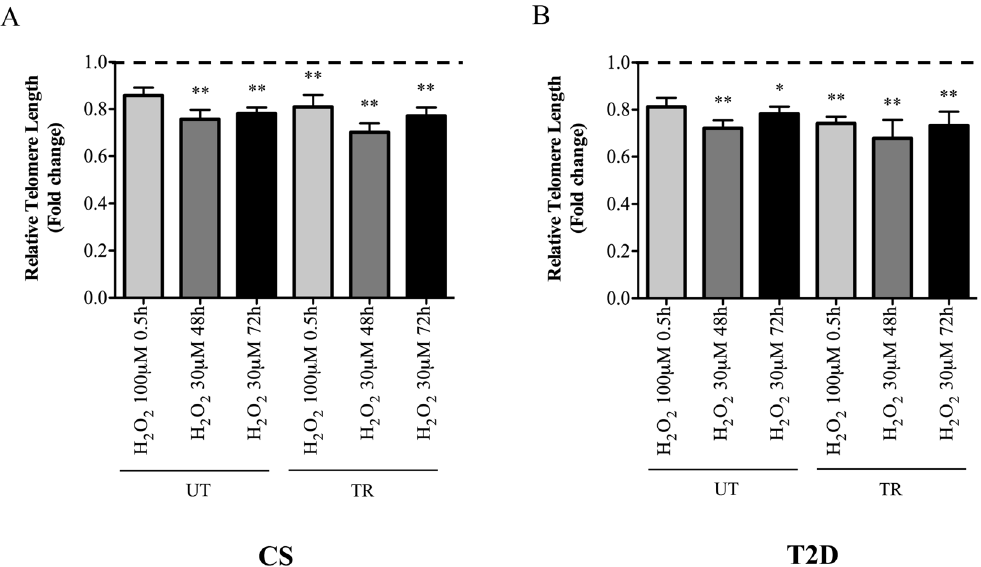
Figure 3. Fold change decrease of telomere length relative to untreated cells in leukocytes of untrained and trained controls (UT-CS: